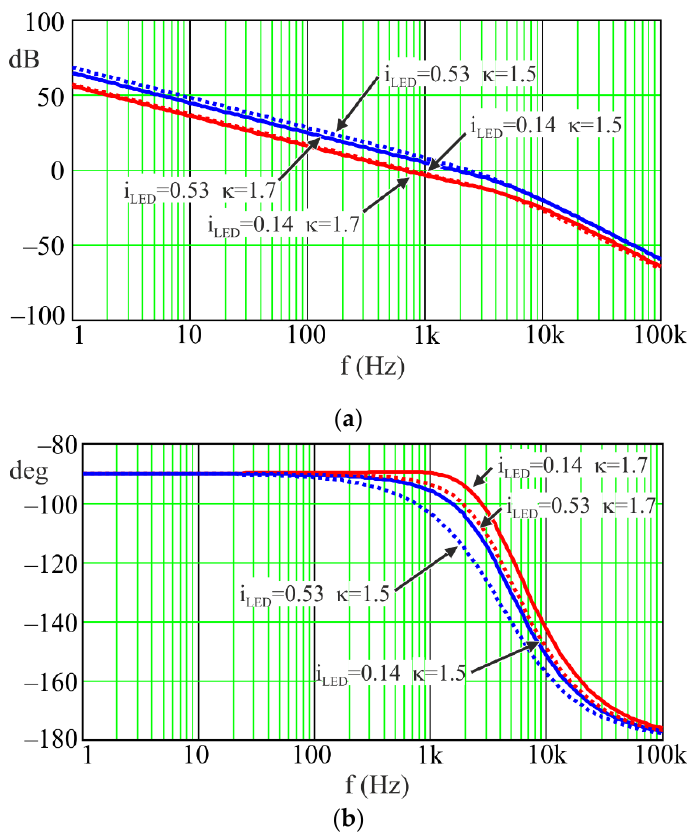
Figure 13. Bode plot of the loop gain: ( a ) gain modulus; ( b ) gain phase.